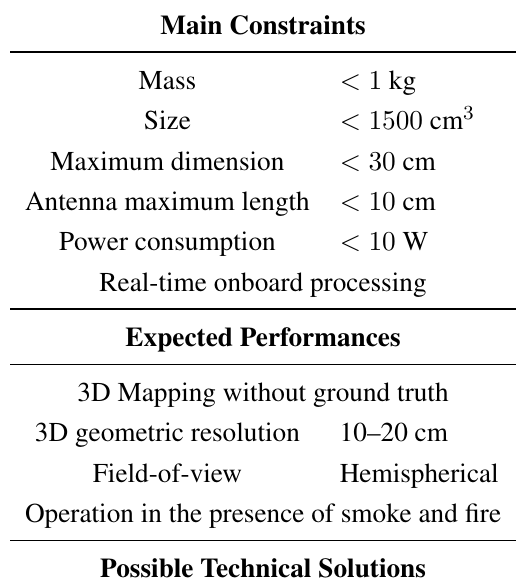
Table 1. Basic design guidelines of the proposed innovative SAR